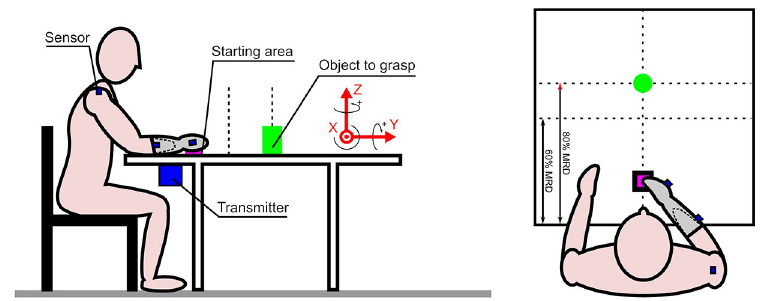
Fig 1. Side view and horizontal view of the experimental set-up.